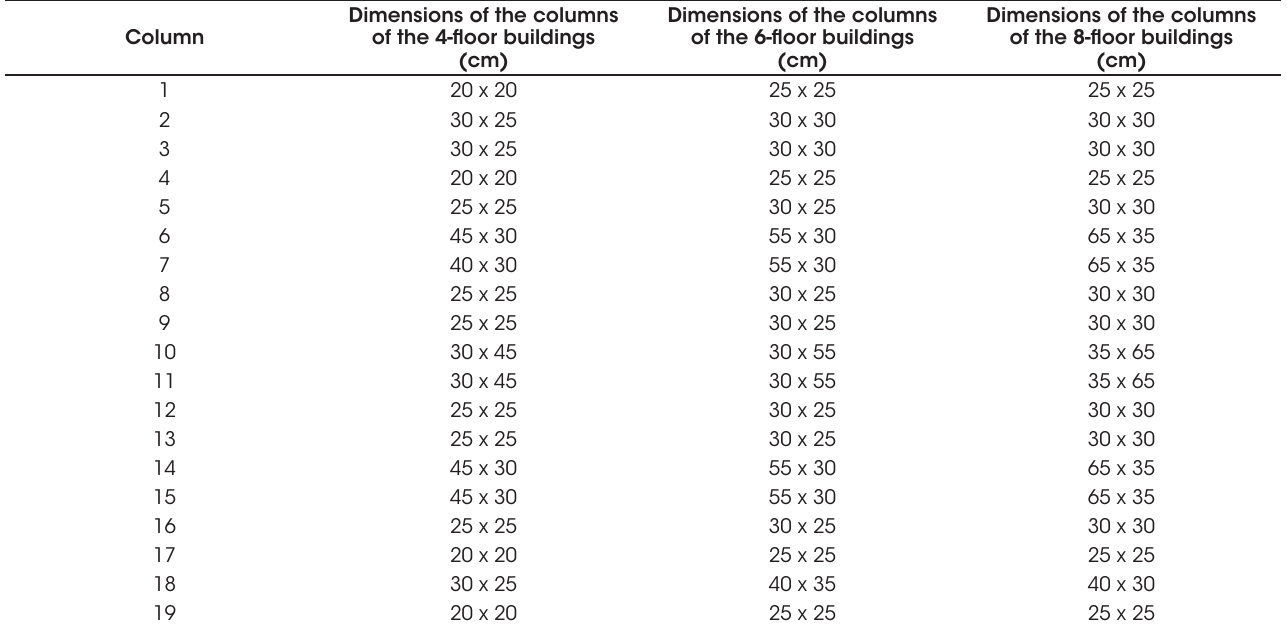
Dimensions of the columns of the 8-floor buildings